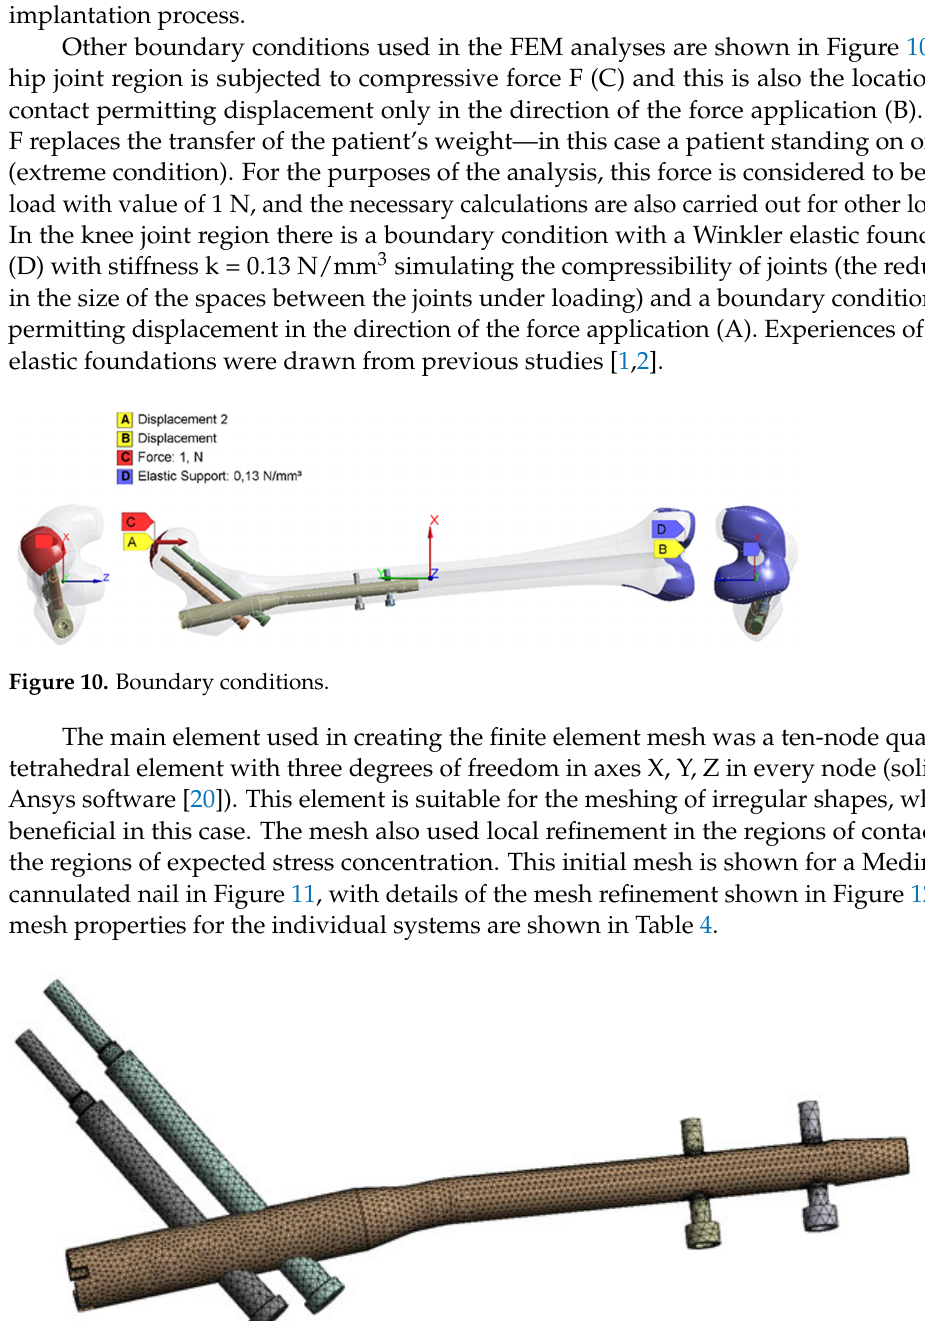
Figure 12. Local mesh refinement for a Medin 125° nail. Table 4. Mesh properties.